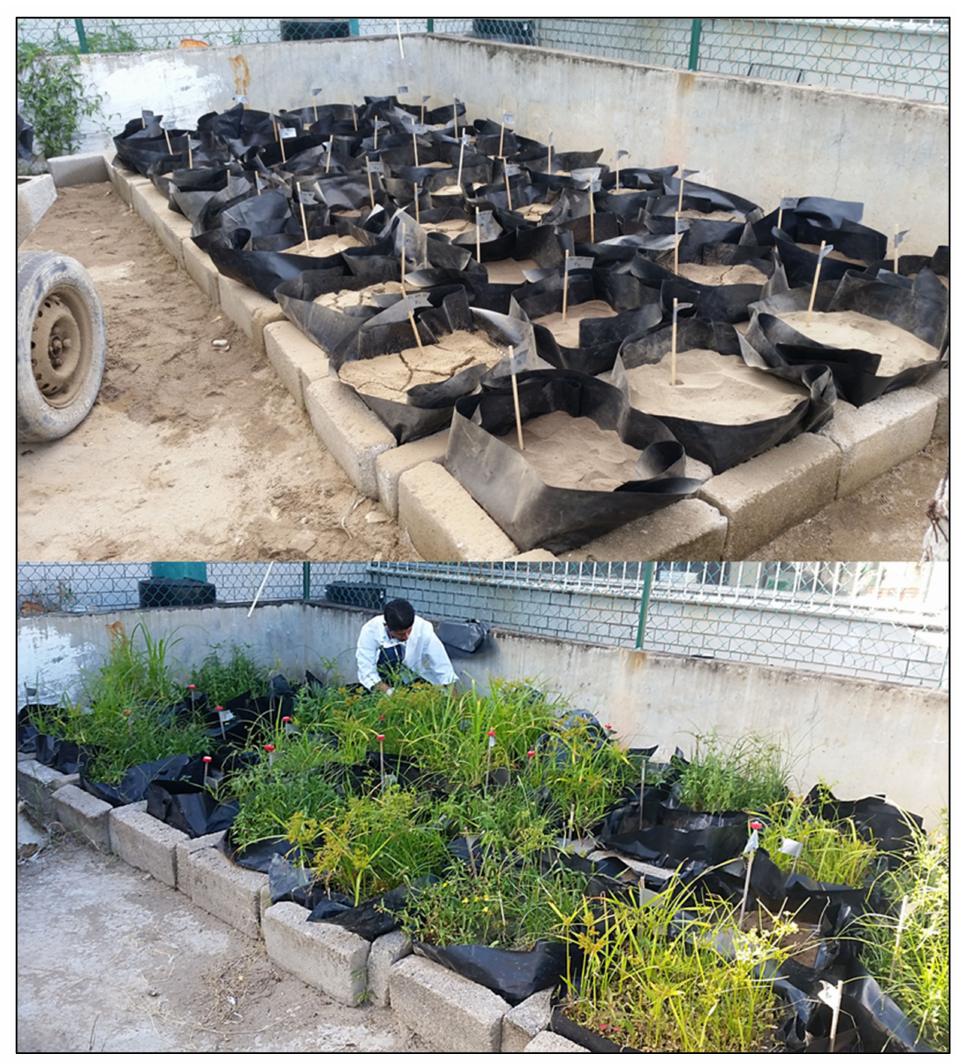
Figure 1. Bioremediation and natural attenuation treatment cells. Above: recently prepared treatment cells. Below: cells after several months of treatment. Note that many cells became naturally vegetated with weedy plants, principally grasses and